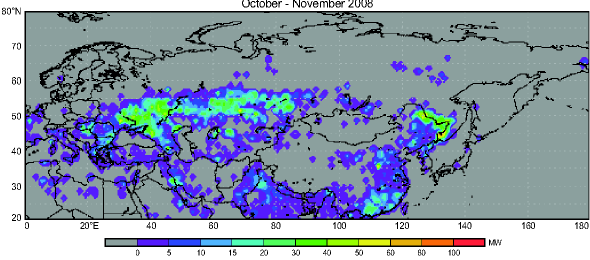
Figure 11. Snow depths as a function of time (monthly averages) for three sampling locations in the Canadian arctic (2009 data set). The data shown are WMO climatological data. For the Inuvik and Walker Lake sites, these data are in good agreement with the measured snow accumulation at the time of sampling. For the Cornwallis Is site, however, there was a substantial discrepancy and the depths were scaled uniformly (upward) to yield the measured total accumulation at the time of sampling.